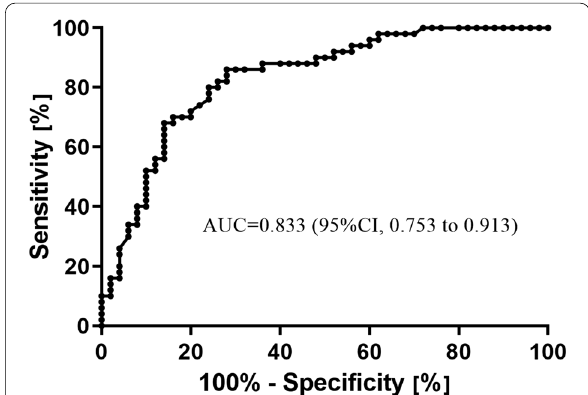
Fig. 2 The receiver operating characteristic (ROC) curve analysis of AFAP1-AS1. The area under curve (AUC) is 0.6779 with 95% CI =